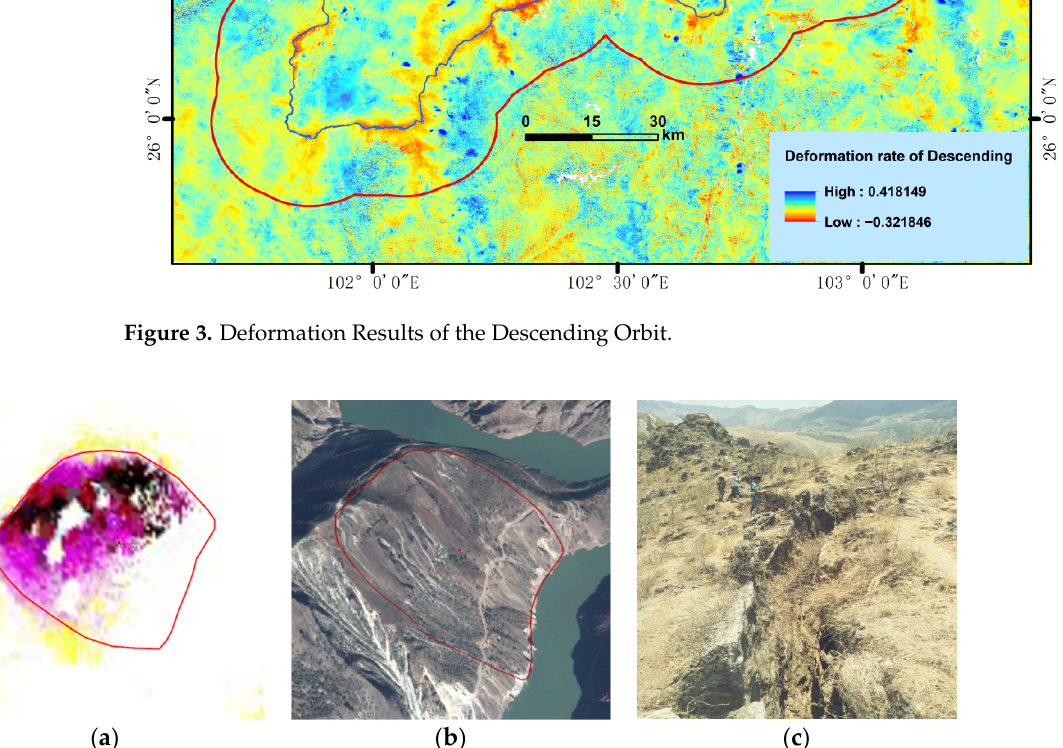
Figure 4. Field verification result of suspected active landslide hazards. ( a ) Deformation accumulation area; ( b ) Optical remote sensing interpretation of landslide hazards; ( c ) Photos of field verification.